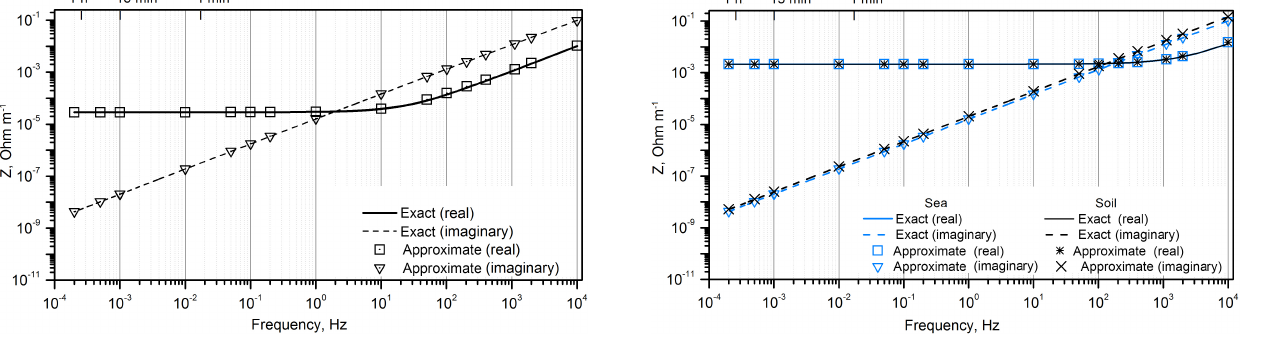
Figure 7. The frequency dependence of impedance of the steel rail calculated by use of the exact (lines) and approximate methods (scatter symbols).